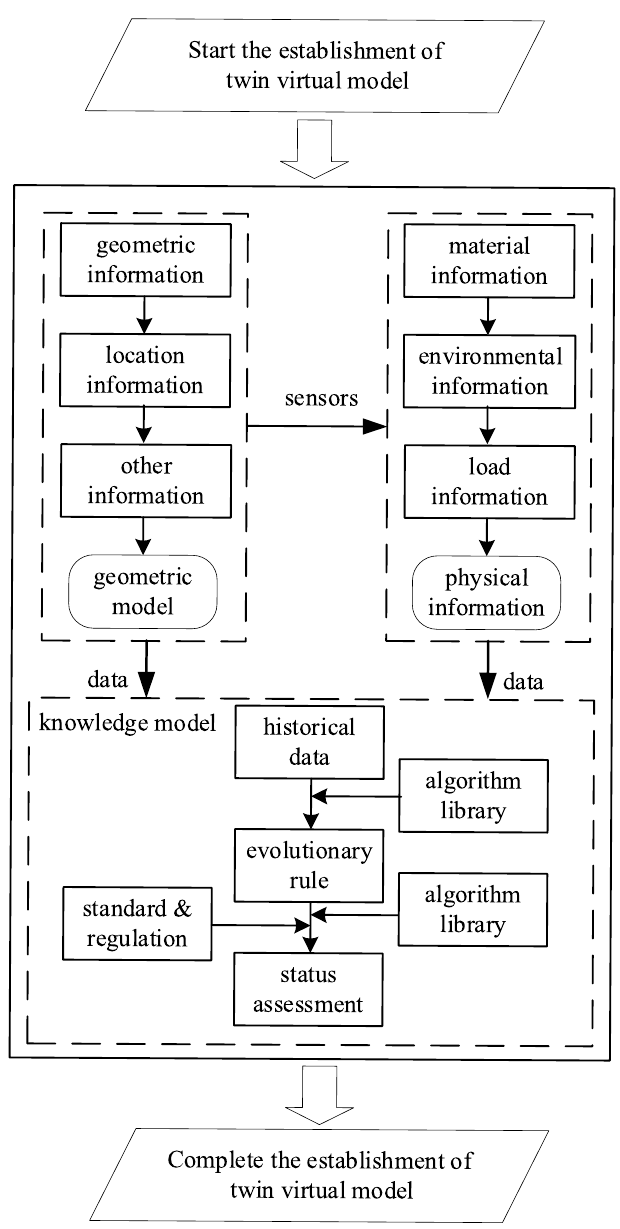
Figure 6. The process of the establishment of a twin virtual